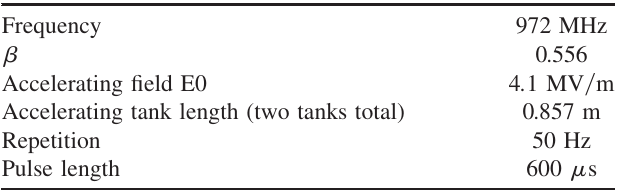
TABLE II. Main parameters for the ACS buncher